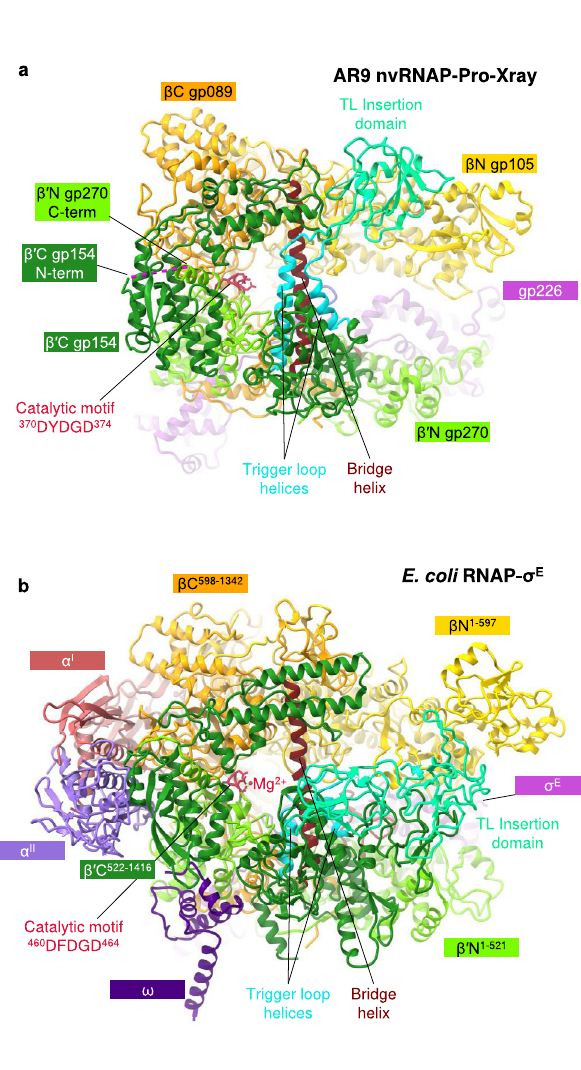
Fig. 3 Comparison of the AR9 nvRNAP and E. coli RNAP- σ E holoenzymes. a , b Ribbon diagrams of the AR9 nvRNAP and RNAP- σ E (PDB code 6JBQ 22 ), respectively, are viewed from the NTP entrance channel. Nucleic acids are not shown for clarity. Gp226 and σ E extend into the plane of the paper and are almost completely obscured by the depth-cueing effect. In both molecules, key elements are colored similarly and labeled. In panel a , the color code is as in Fig. is present in all known RNAPs. It extends from one of the β ′ clamp α -helices and interacts with the RNA-DNA hybrid near the active site 12 . In bacterial RNAPs, deletion of the β ′ rudder impairs promoter opening and destabilizes the elongation complex but